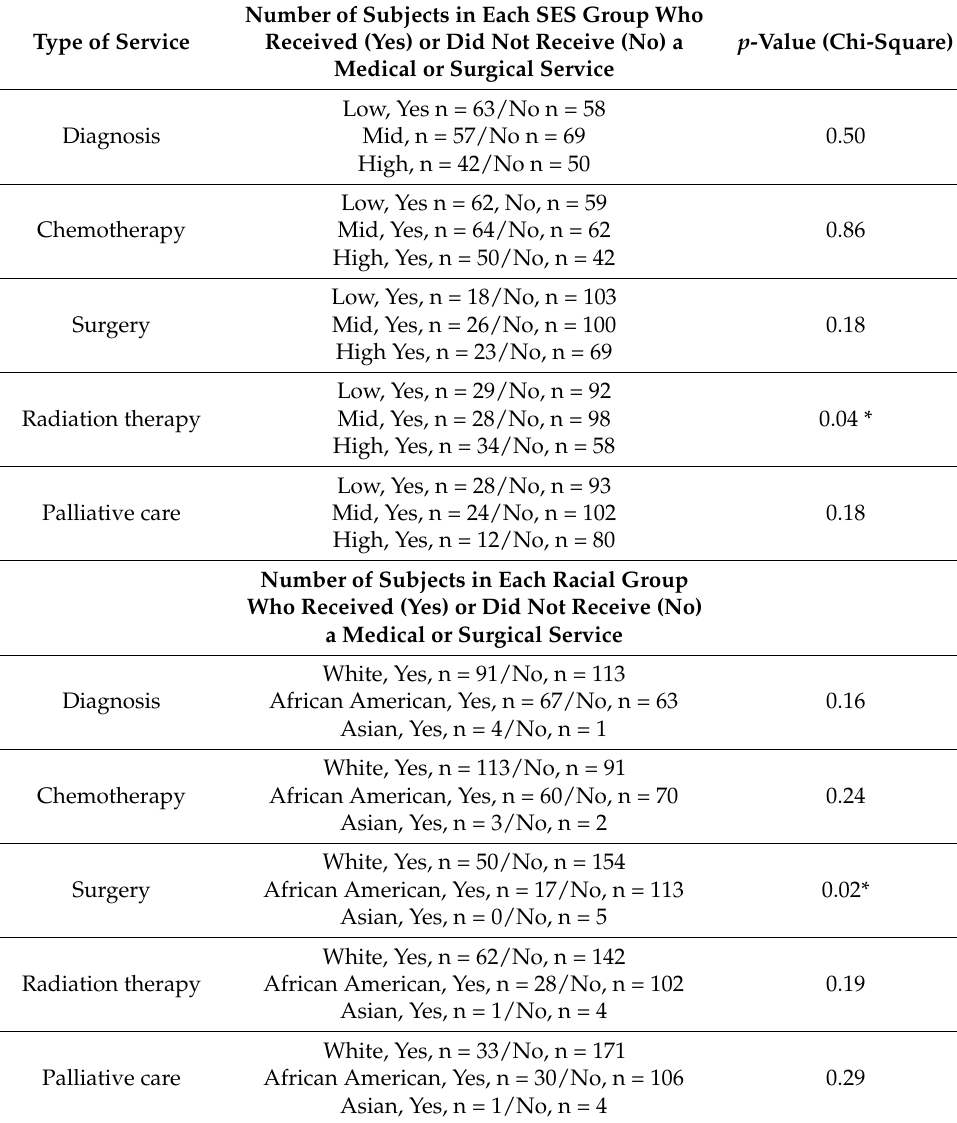
Table 4. Utilization of services by SES or race. Distribution of the number of subjects, grouped by SES or race, who received one or more medical or surgical services. Comparative statistics (chi-square) were performed on the total sample, including subjects who did not receive any type of these services. A significantly different and non-random distribution (*) was detected (chi-square) between SES and receiving or not receiving radiation therapy. A significantly different and non-random distribution (*) was also detected in subjects based on race and undergoing or not undergoing surgical